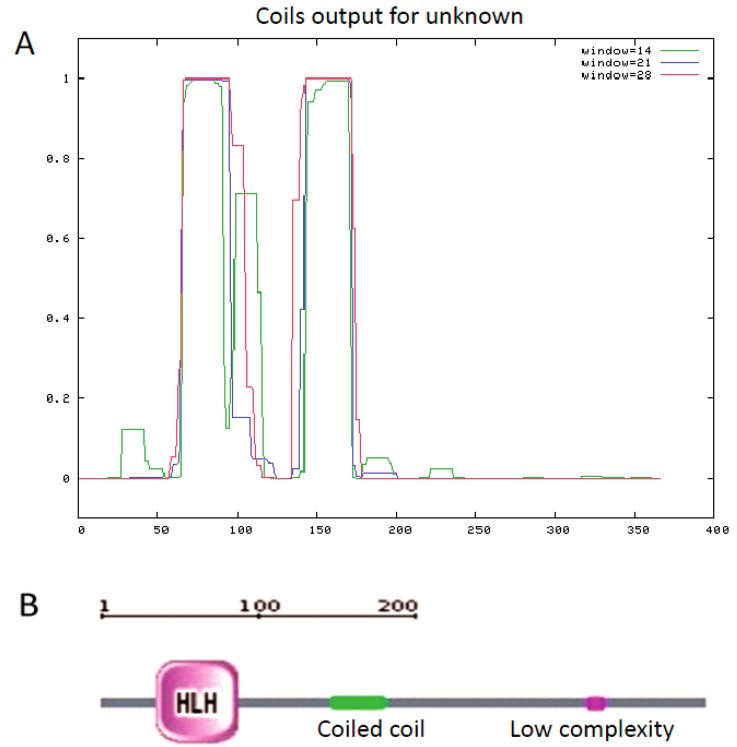
Figure 2. Analysis of the functional domains of the Stra8 amino acid sequence. ( A ) using COILS program; ( B ) using SMART